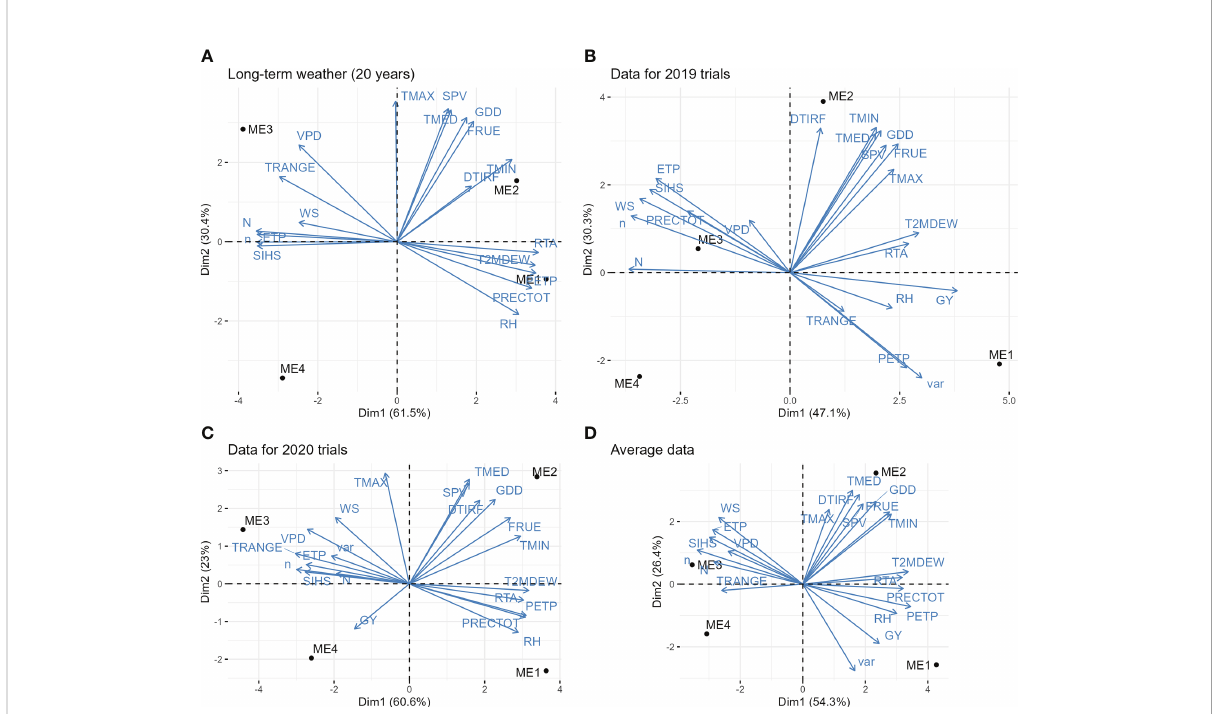
FIGURE 3 Biplot for the principal component analysis between environmental variables. (A) long-term pattern data (average of 20 years of climate information); (B) observed climate variables in the trials during 2019; (C) observed climate variables in the trials during 2020; (D) average information of the two years of trials. The variables are: grain yield (GY), genotype variance within mega-environment (var); average air temperature (TMED, °C d -1 ); minimum air temperature (TMIN, °C d -1 ); maximum air temperature (TMAX, °C d -1 ); dew-point temperature (T2MDEW, °C d -1 ) at 2 m above the surface of the earth at 2 m above the surface of the earth; total rainfall precipitation during the crop cycle (PRECTOT, mm); daily temperature range (TRANGE, °C d -1 ), de fi cit by precipitation (PETP, mm d -1 ); air relative humidity (RH, %), potential evapotranspiration (ETP, mm d -1 ); slope of saturation vapor pressure curve (SVP, Kpa °C d -1 ); vapor pressure de fi cit (VPD, kPa); Effect of temperature on radiation-use ef fi ciency (FRUE); Growing Degree Day (GDD, °C day − 1 ); Actual duration of sunshine (n, hours); Daylight hours (N,